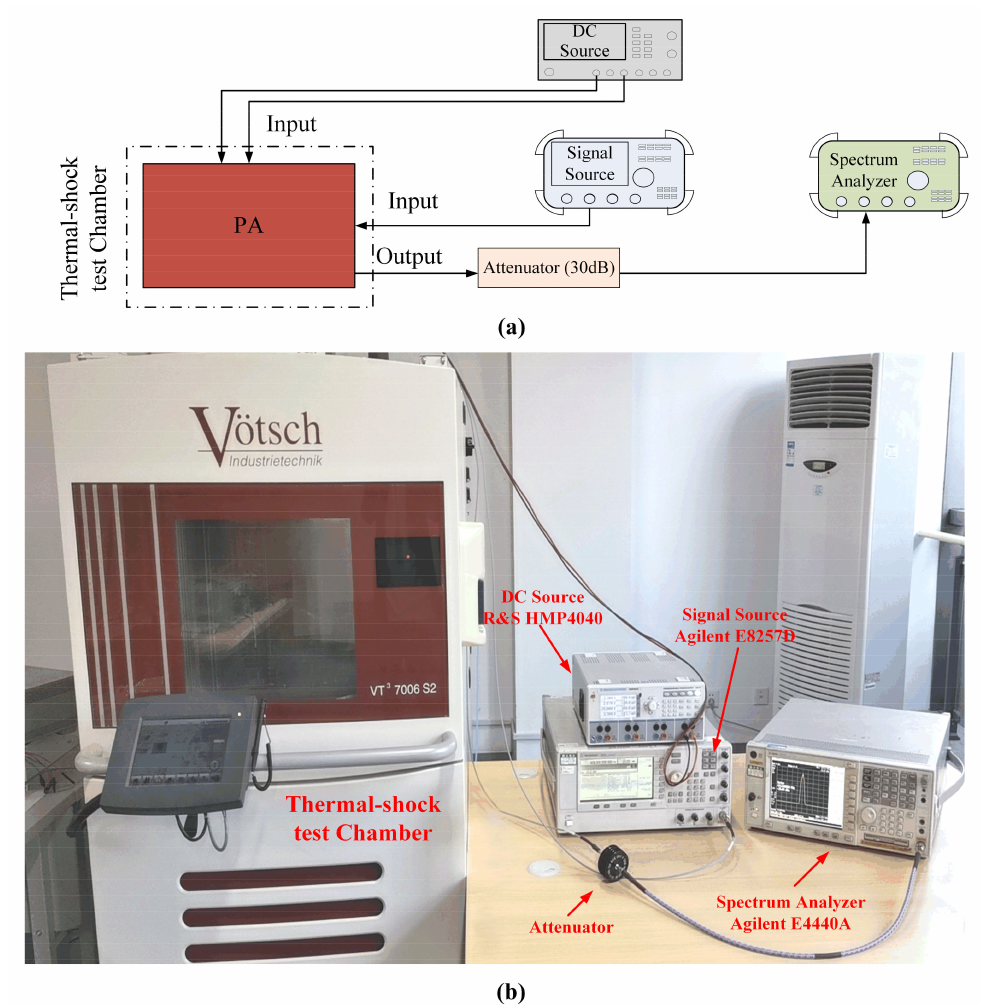
Figure 2. The thermal shock test environment. ( a ) The logical relationship of the test system; ( b ) the physical deployment of the test